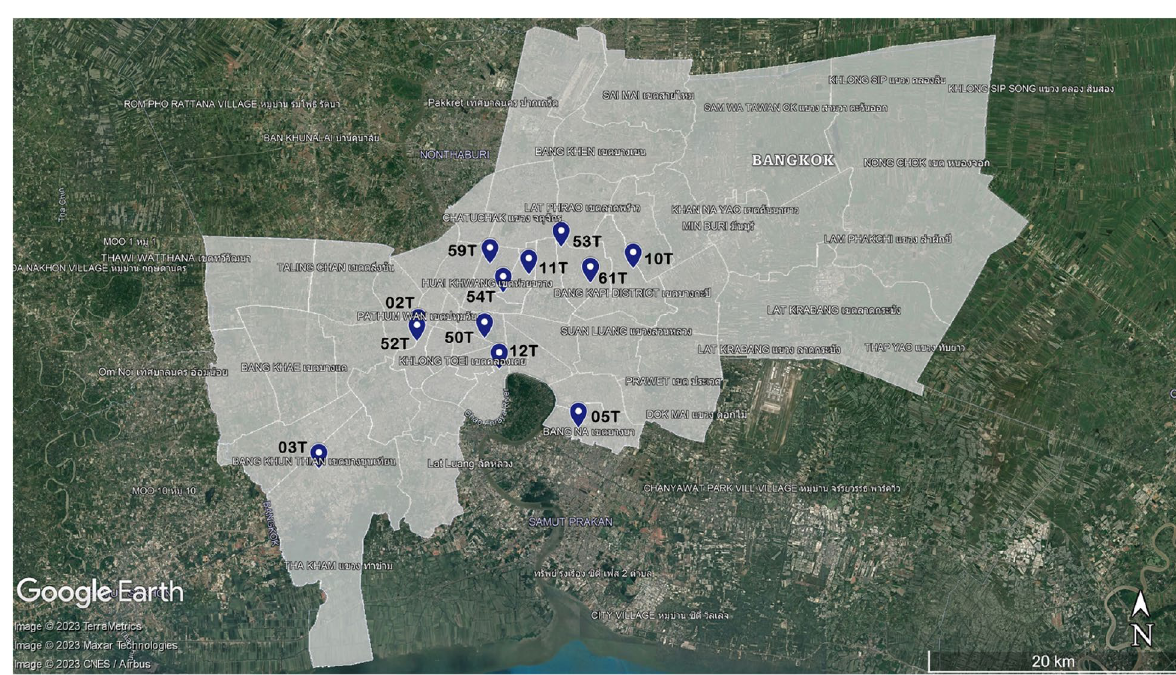
Fig. 1 Locations of air quality monitoring